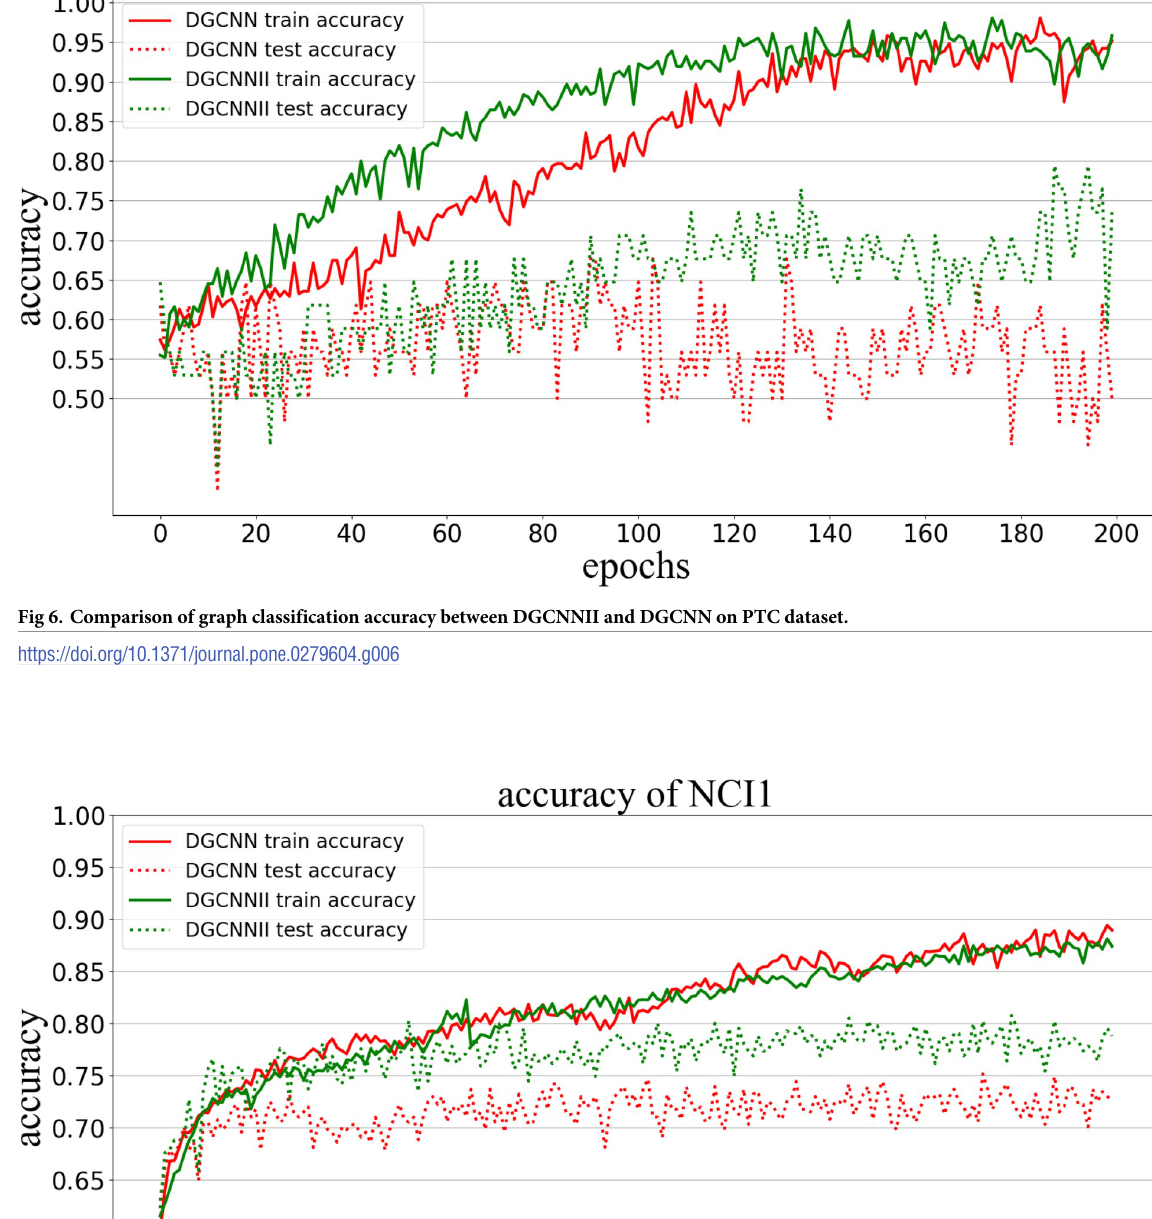
PLOS ONE | https://doi.org/10.1371/journal.pone.0279604 March 10, 2023 22 /